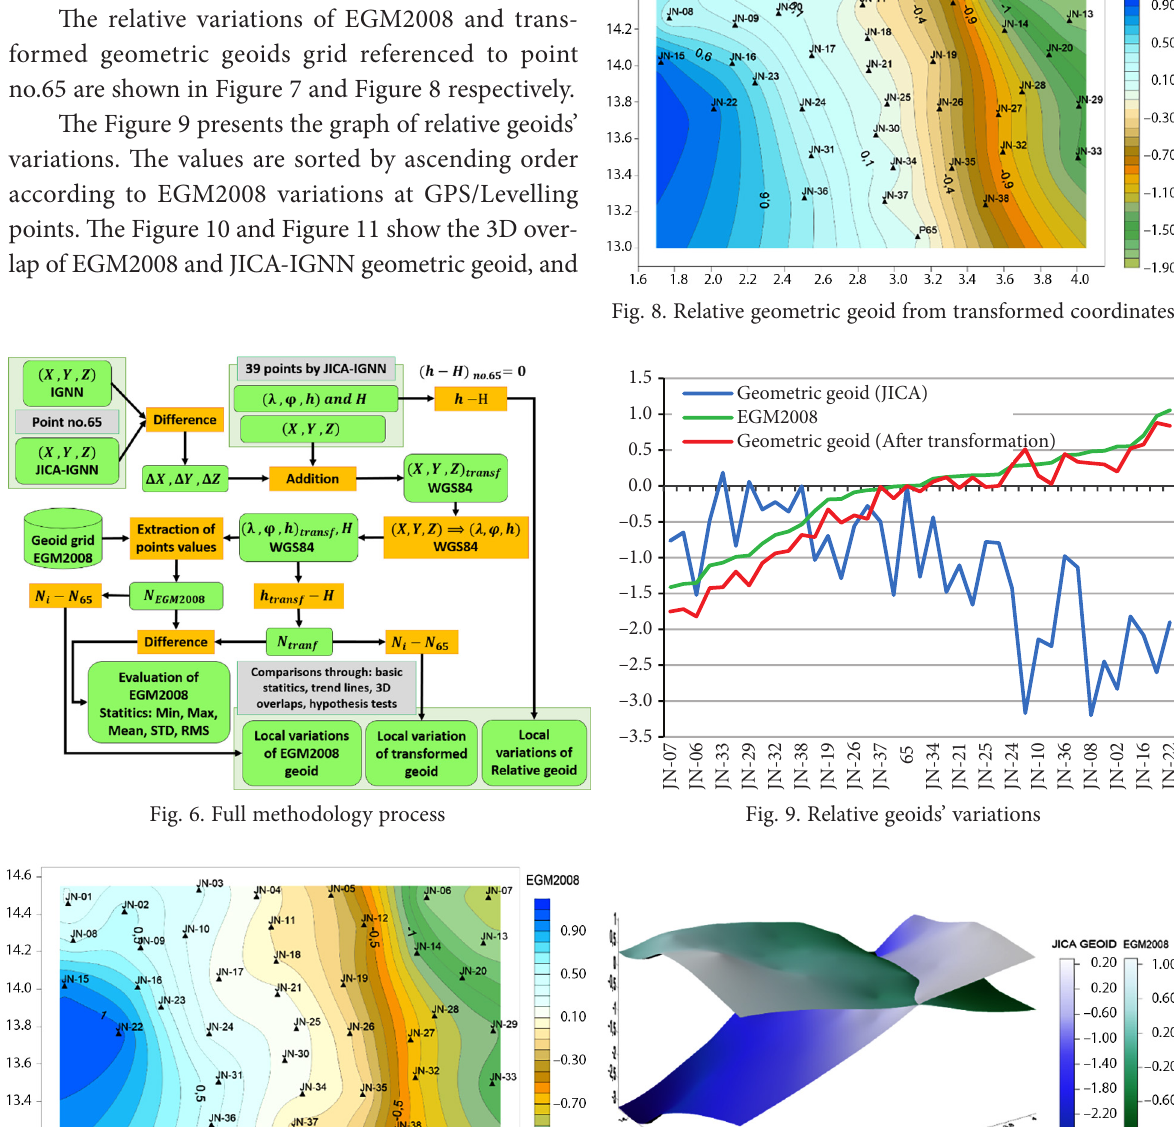
Fig. 7. Relative geoid of EGM2008 referenced to point no. 65